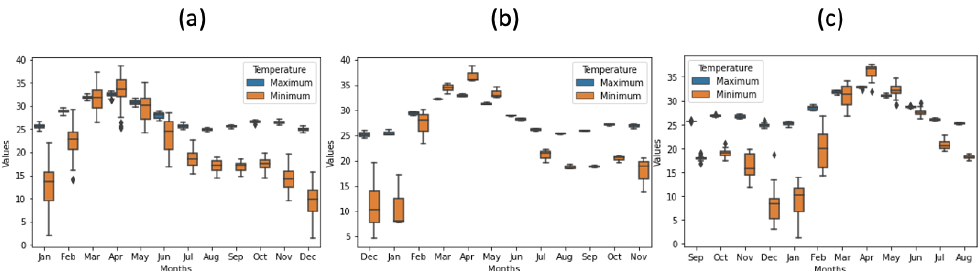
Figure 8. Boxplot of monthly minimum and maximum temperatures data, displaying the heteroge- neous spread in ( a ) the training, ( b ) the validation and ( c ) the test sets.